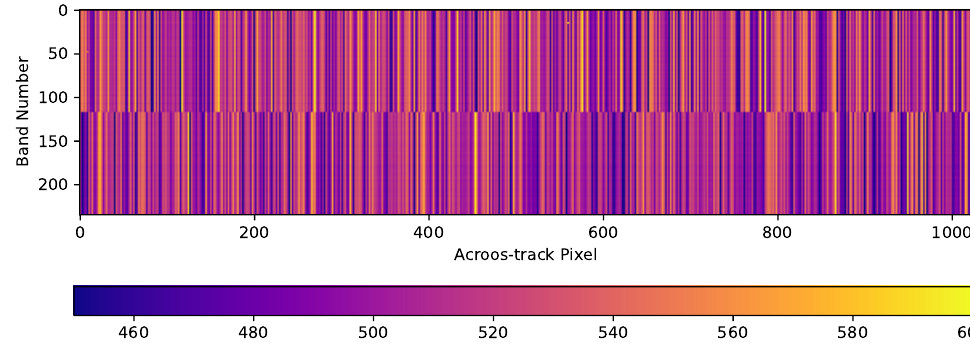
Figure 7. Historical averaged dark current